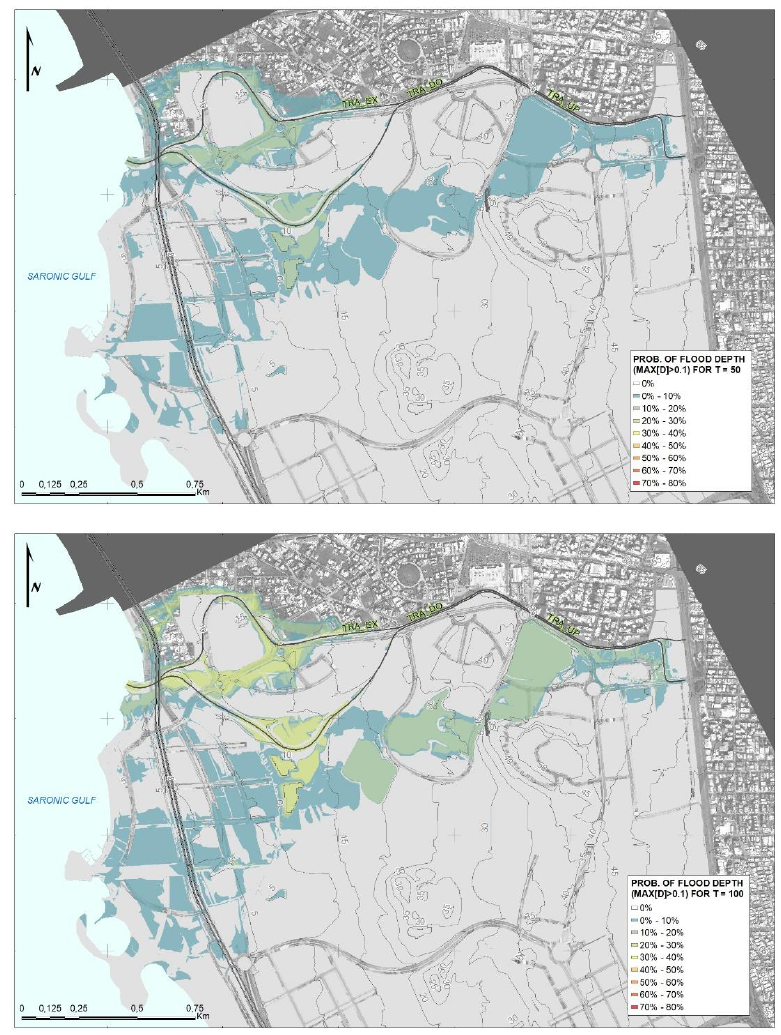
Figure 14. Probability of depth >0.1 m (curb height), for a rainfall event with 𝑇 = 50 years ( top ) vs. 100 years ( bottom ).